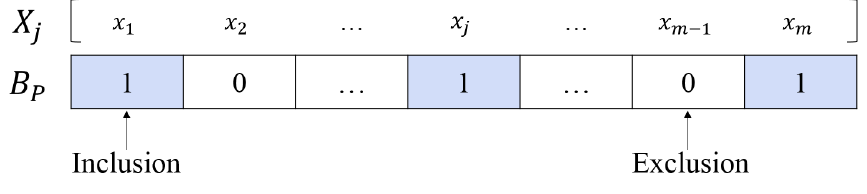
Figure 2. Representation of an individual as a binary